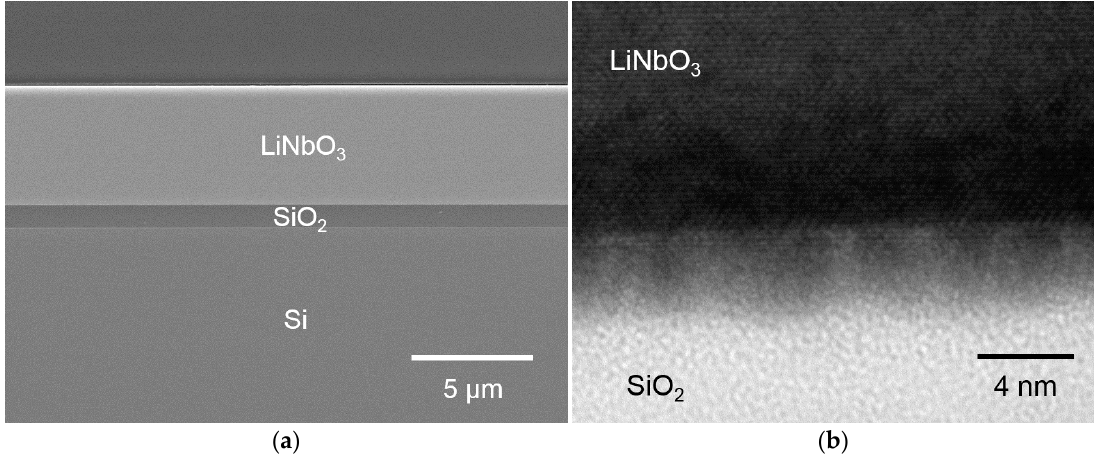
Figure 3. ( a ) Cross-sectional scanning electron microscopy (SEM) image of the LNOI/Si hybrid wafer. ( b ) Cross-sectional transmission electron microscopy (TEM) image of the LN/SiO 2 bonding interface.